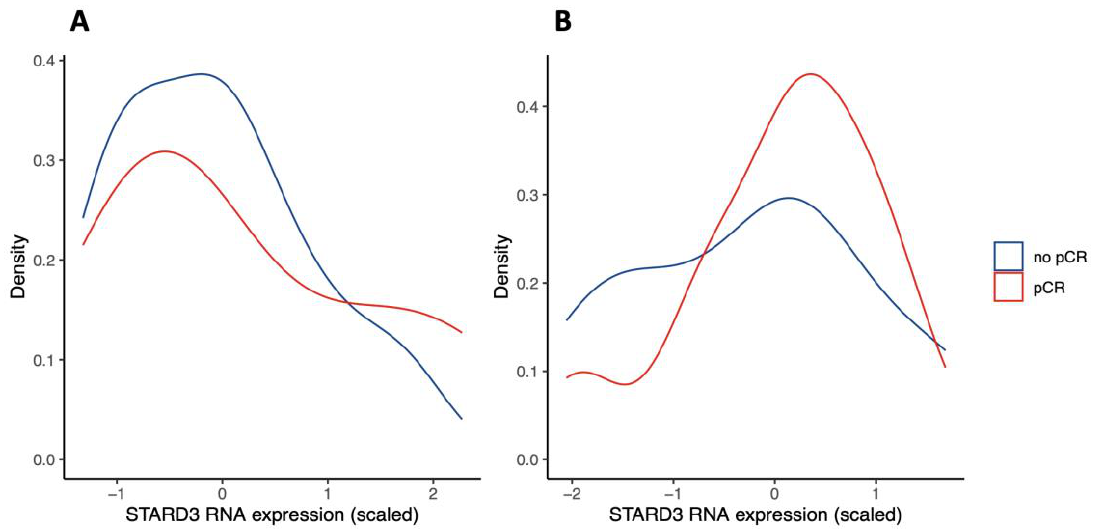
Figure 5. STARD3 gene expression in Gene Expression Omnibus (GEO) repository studies (density plots). Legend: panel ( A ) shows scaled STARD3 gene expression (RNA sequencing) in a study of n = 24 initial biopsies [26]. Panel ( B ) shows scaled STARD3 gene expression (RNA sequencing) in a study of n = 57 initial biopsies [27].